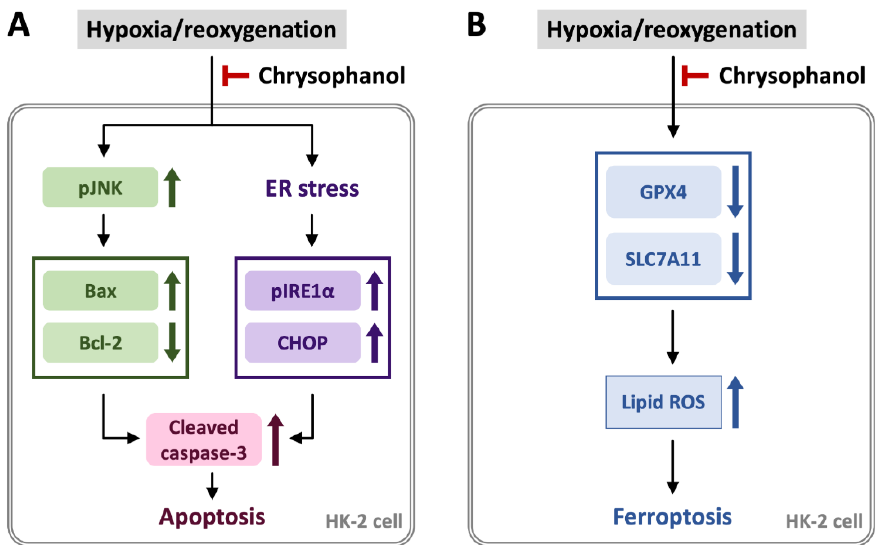
Figure 5. A summary diagram outlining the working mechanisms of chrysophanol in HK-2 cells under H/R conditions. ( A ) H/R increased apoptosis via upregulation of p-JNK, Bax, down-regula- tion of Bcl-2 and ER stress via upregulation of p- IRE1α/ CHOP. Moreover, chrysophanol prevented apoptosis and ER stress by reversing the expression of indicated molecules. ( B ) H/R triggers ferrop- tosis via downregulation of GPX4 and SLC7A11, as well as lipid ROS overproduction. ( B ) Chrysoph- anol prevents H/R-induced ferroptosis via upregulation of GPX4 and SLC7A11, as well as decreas- ing lipid ROS accumulation. lipid ROS